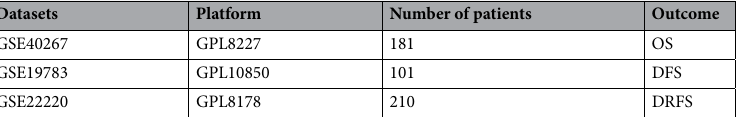
Table 3. Additional GEO datasets that served as independent validation datasets. OS Overall survival; DFS disease-free survival; DRFS distant-relapse free survival.